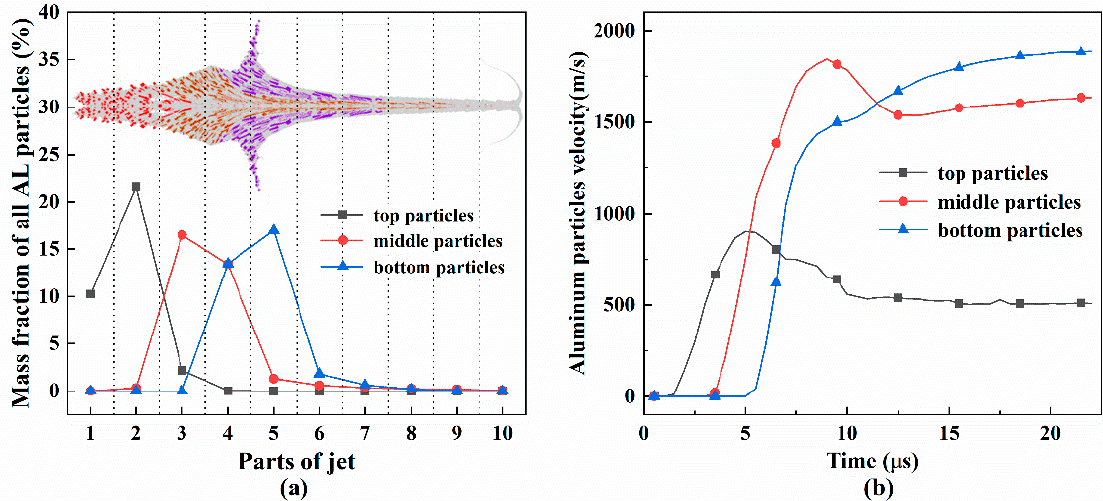
Figure 16. Velocity and mass fraction of Al particles from different parts: ( a ) mass distribution of Al particles from different parts along the jet axis at 2 CD standoff; ( b ) average velocity of Al particles from different parts.